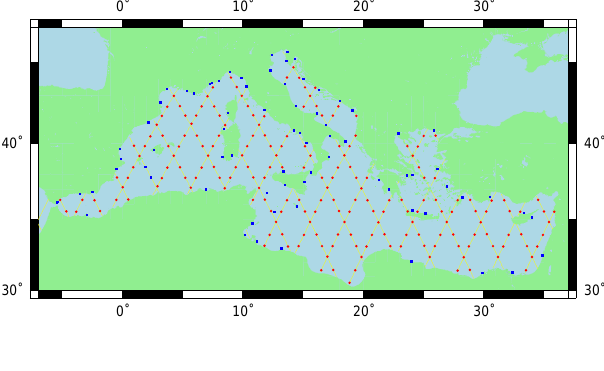
Fig. 3. Representers and data sites used for the computation of